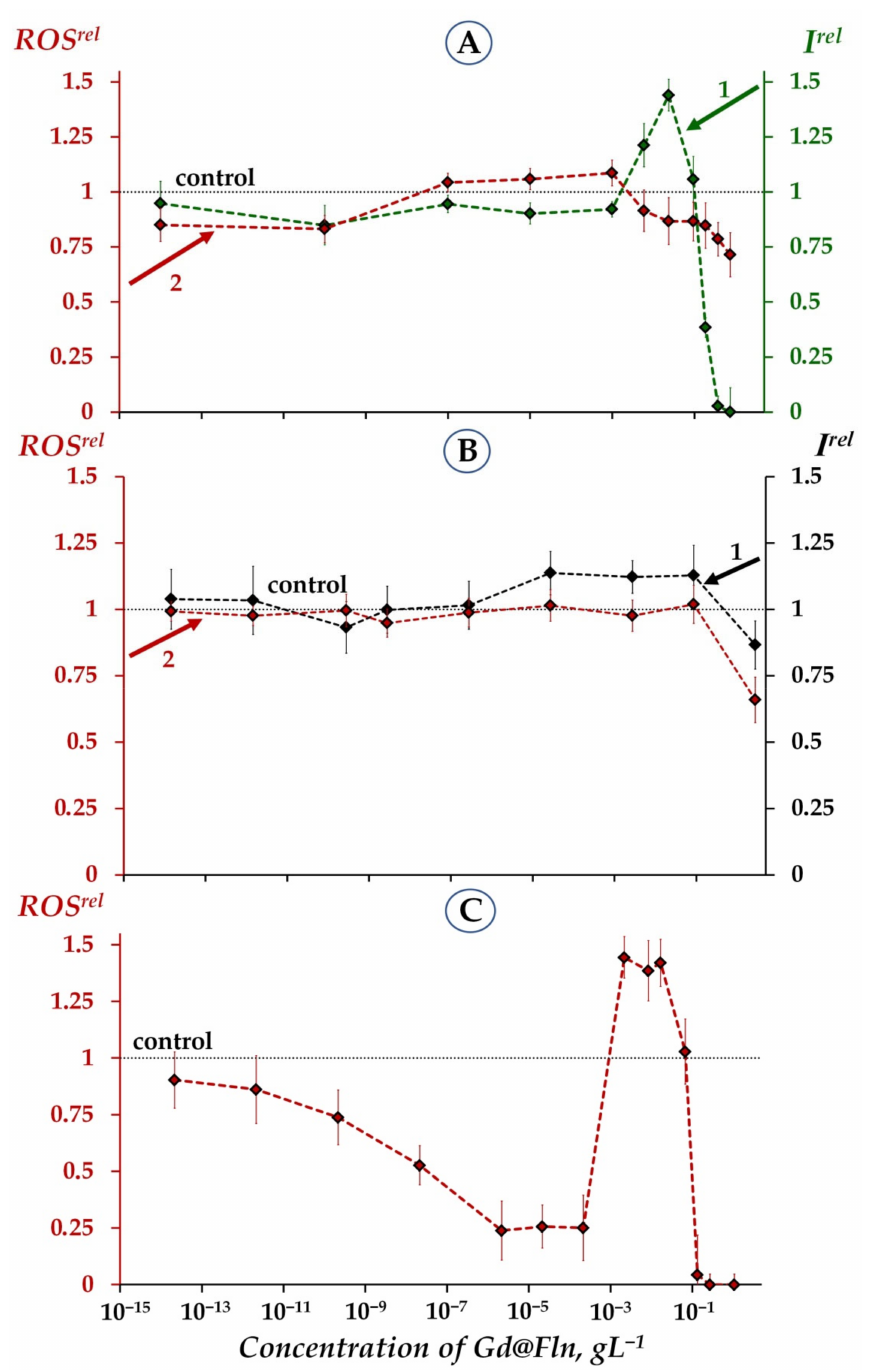
Figure 2. Relative bioluminescence intensity, I rel , (1) and relative ROS content, ROS rel , (2) in bac- terial suspension ( A ), enzymatic system ( B ) and distilled water ( C ) at different concentrations of fullerenol Gd@Fln. Time of exposure to Gd@Fln was 1 min. Concentration of ROS in the control bacterial suspension was ~4.5 · 10 − 6 M, in the control enzymatic sample—1.9 · 10 − 5 M, in distilled water—3 · 10 − 7 M. “Control” corresponds to the absence of Gd@Fln in the experimental